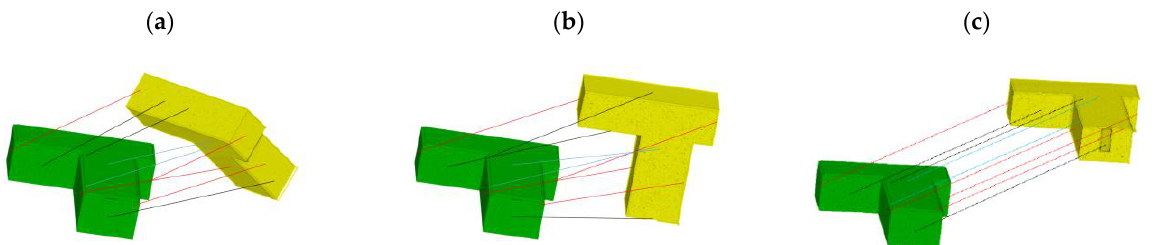
Figure 7. Visualization of the as-built model (yellow) corresponding to the as-planned model (green), with an incorrect orientation ( a , b ) and correct orientation ( c ). The lines connecting the matching segments in all orientations represent the corresponding translation.